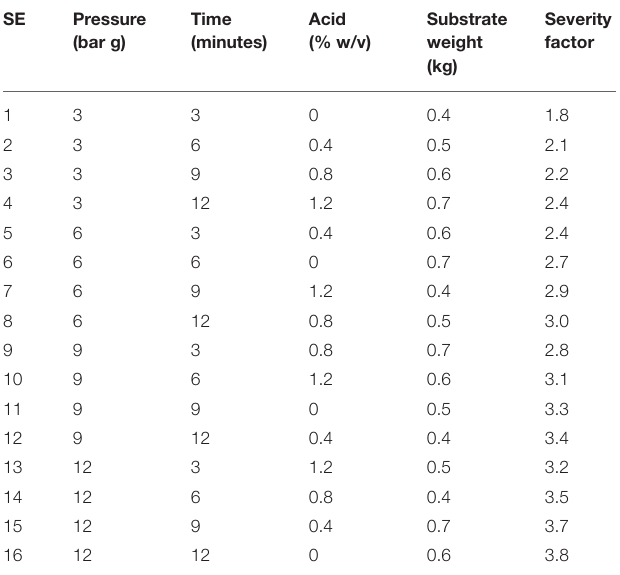
TABLE 1 | L 16 orthogonal array of designed experiments with factors, levels and associated severity factors. SE